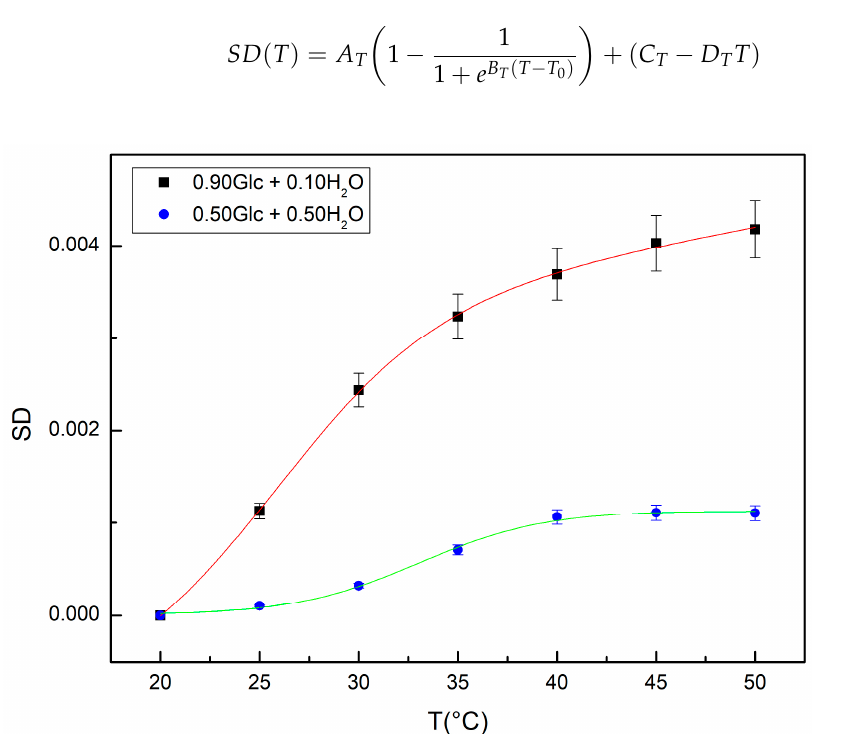
Figure 6. Values of SD calculated for the concentration of 90% glucose and 10% water (black square) together with the model fit (red curve) and values of SD calculated for the concentration of 50% glucose and 10% water (blue circle) together with the model fit (green curve).